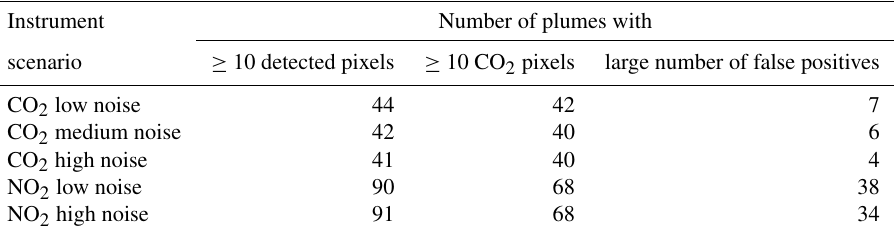
Table 8. Number of plumes detected for Jänschwalde with six satellites. The number of plumes are provided for plumes with at least 10 detected CO 2 or NO 2 pixels and in addition with at least 10 CO 2 pixels (cloud cover < 1%). In both cases, plumes were included where neighboring plumes were detected in addition to Jänschwalde, i.e., detection with a large number of false positives (e.g., Fig. 13c). These plumes are also shown separately. The classification uncertainty is about ± 5 plumes. The neighborhood size was set to n s = 5.